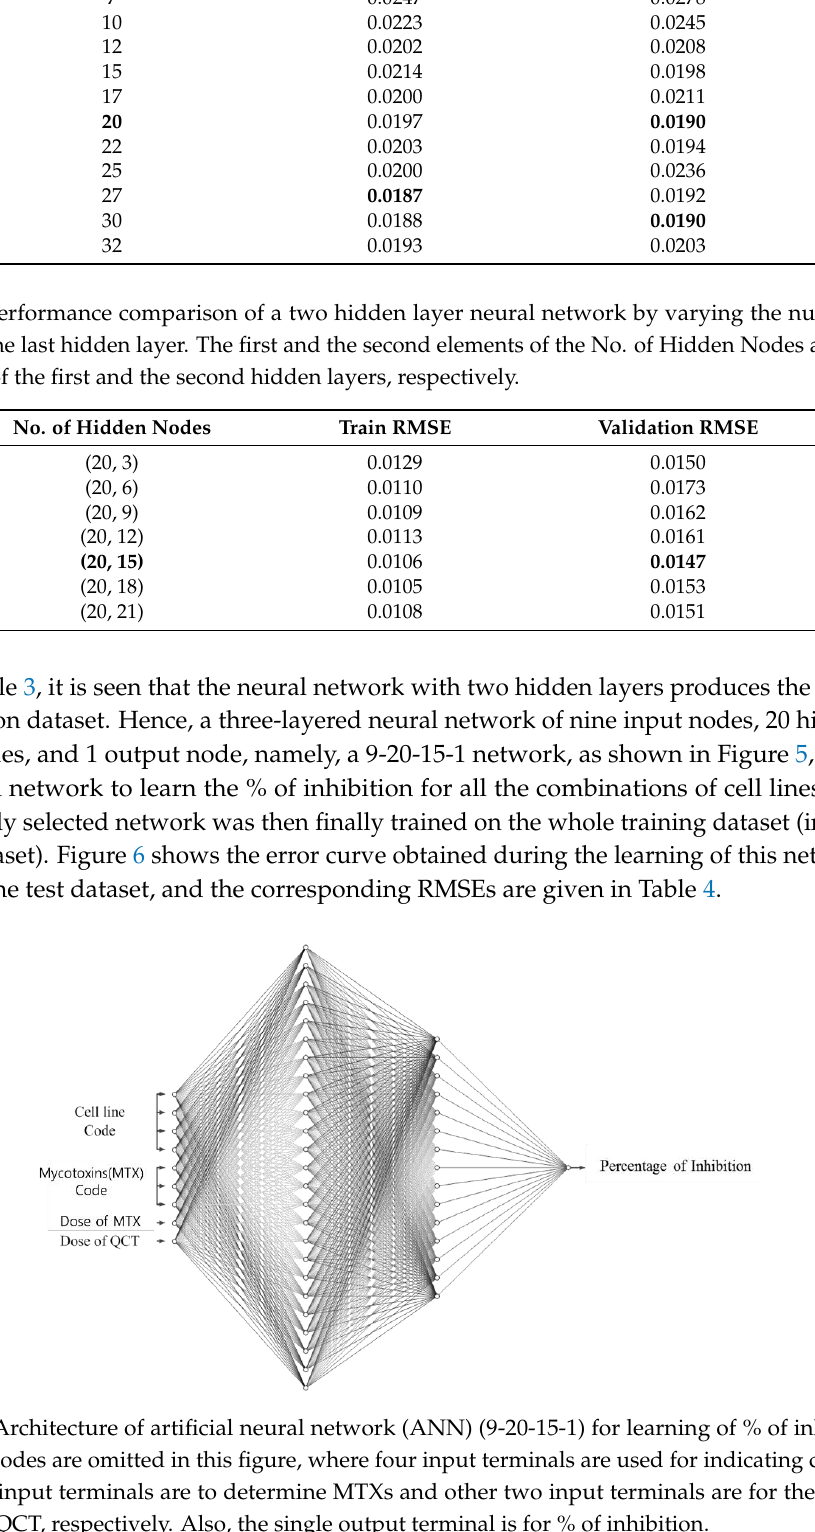
Figure 6. Error curves of learning % of inhibition on the training and the test set. Root mean square error ( rmse ) is employed to evaluate the performance and the network is trained for 10,000 epochs or until the rmse reaches 0.01, whichever occurs first. (The x -axis is plotted in log scale.) Table 4. Performance of the final 9-20-15-1 network on the train and test dataset. Network Train RMSE Test RMSE 9-20-15-1 0.0110 0.0111 After the learning was completed, the network was evaluated on the test set and the % of inhibition values were obtained from the output of the ANN. The % of inhibition surface obtained from the trained neural network for Hep G2 cell lines with MTX CTN ranging from 0 to 200 µM for different doses of QCT ranging from 0 to 20 µg/mL is presented in Figure 7. Note that the increasing directions of QCT and CTN axis are indicated by arrow heads. The experimentally measured data is superimposed on this surface with solid circles. The black solid circles are the % of inhibition values used for training the ANN and the blue and red circles are those of test data. The solid circles hidden partially in the surface indicate that the % inhibition values predicted by the ANN are close to the experimentally measured data. For better visualization of the modeling accuracy of the ANN on the